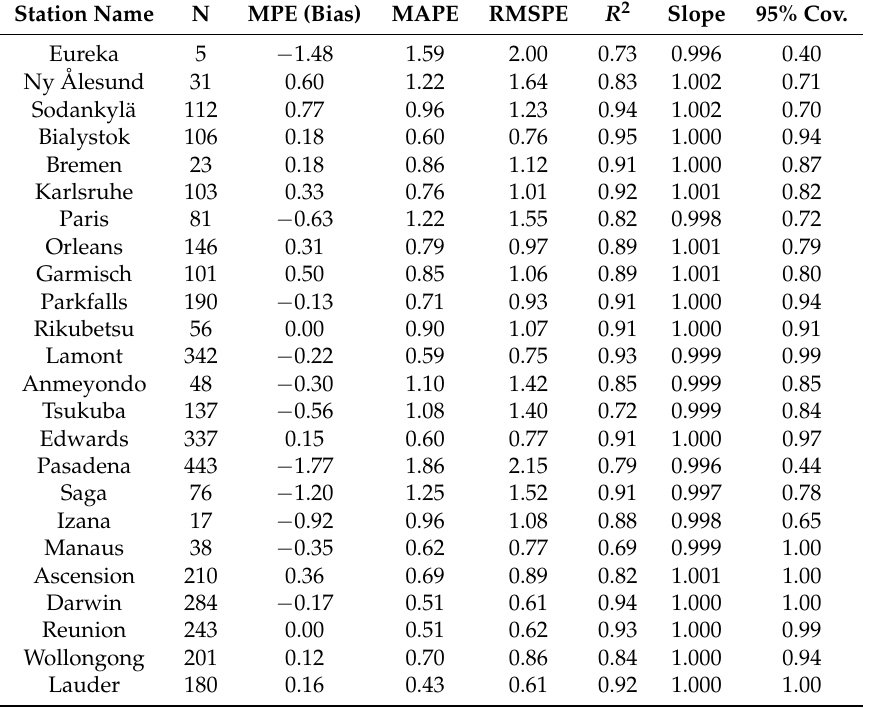
Table A2. Same as Table A1, but for the fixed rank kriging Version 8r